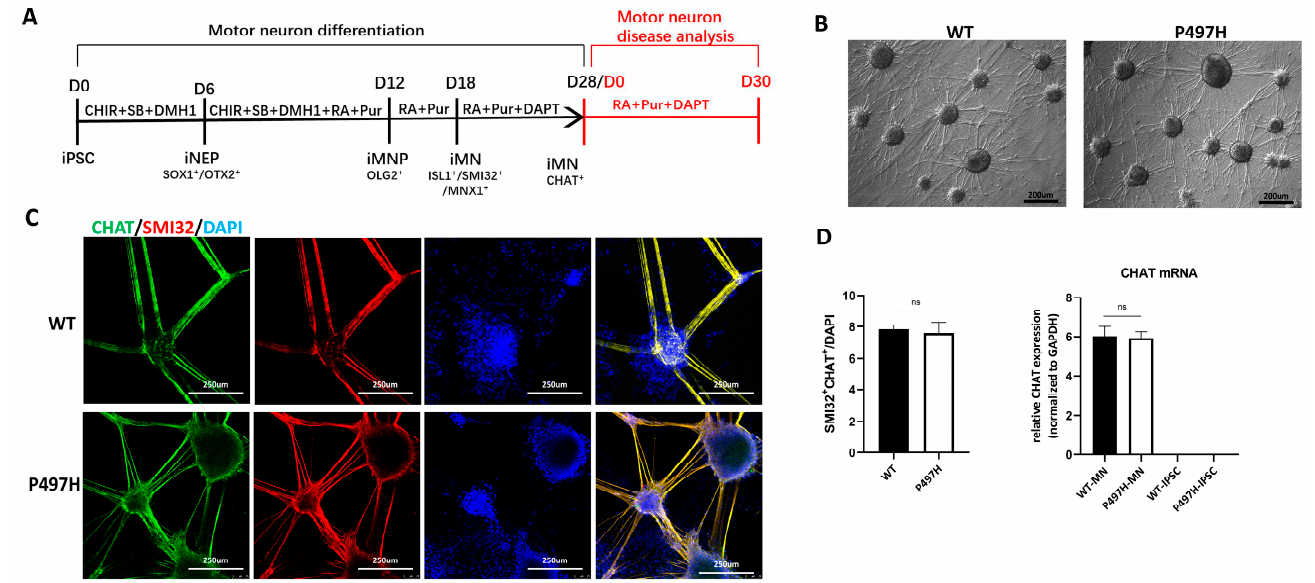
Figure 2. Characterization of spinal motor neuron differentiation potential. ( A ) Schematic protocol for MN differentiation. The red character indicates that MNs continue to be cultured in vitro for disease analysis after differentiation and maturation, and the mature motor neurons obtained are recorded as day0. Abbreviations: iNEP, induced neuroepithelial progenitor; MNP, motor neuron progenitor; iMN, induced motor neuron; D, days; RA, retinal acid; CHIR, CHIR99021; SB, SB431542. ( B ) Bright field image of representative WT and mutant MNs at day 28. ( C ) Immunostaining of spinal motor neuron markers CHAT and SMI32 at day 28. DAPI was used to visualize the nucleus; see Figure S1 for iNEP, MNP, and iMN differentiation. ( D ) Through the quantification of ( C ) (n = 10) and qRT-PCR, we analyzed the expression of mature MNs and iPSC-related gene CHAT. Data are shown as mean ± SD (ns, not significant).